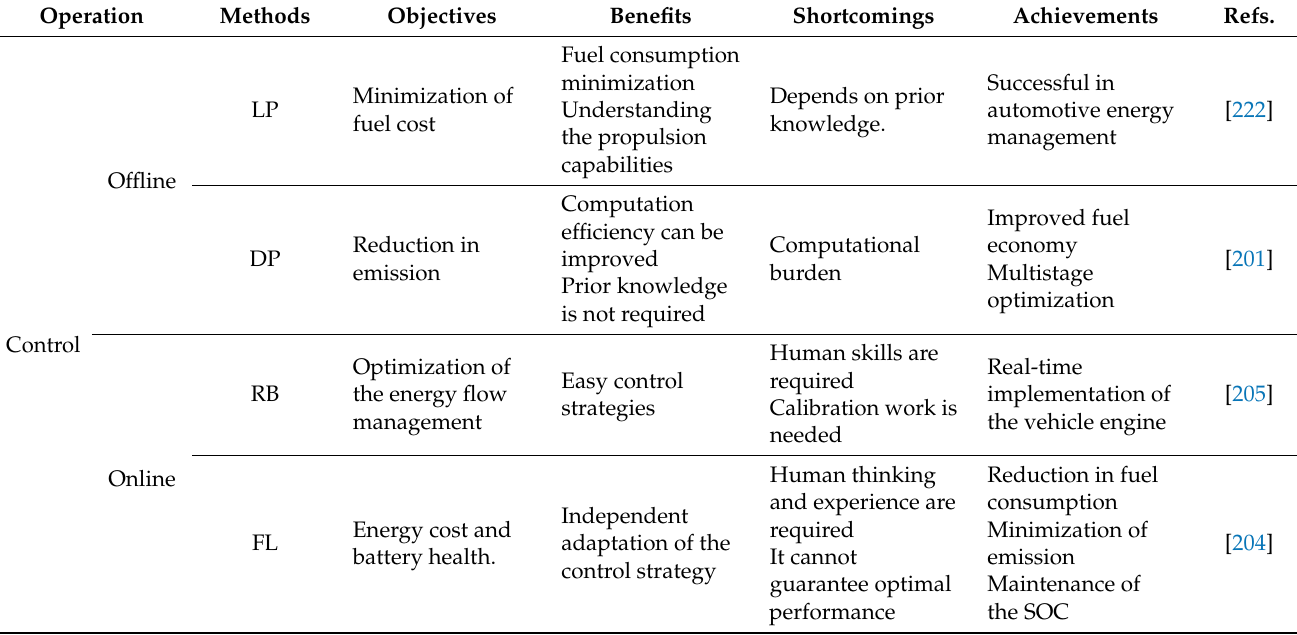
Table 5. The control strategies and optimization schemes are applied for EV applications.